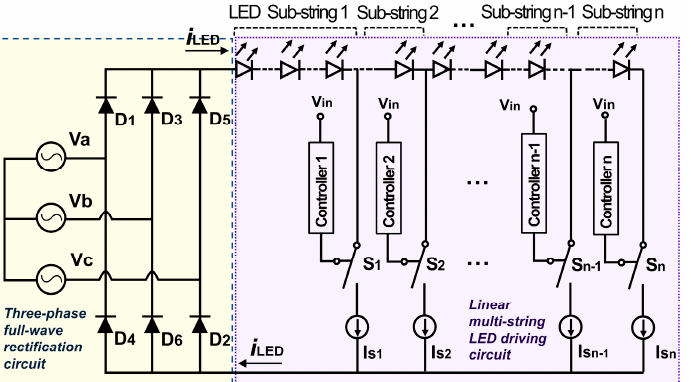
Figure 1. Equivalent circuit diagram of the novel pulsating DC high-voltage linear driving scheme for multi-string GaN LED.